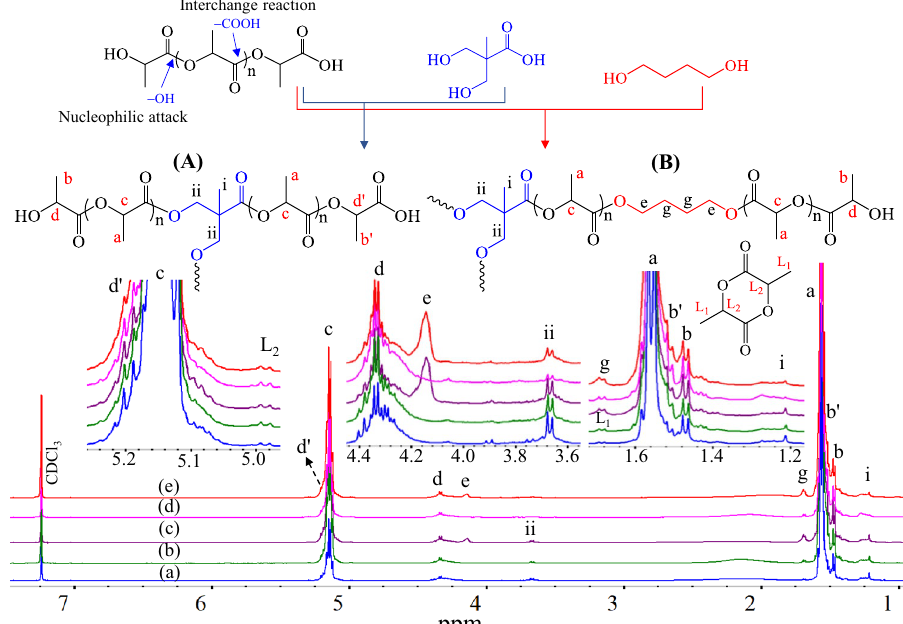
Figure 3. 1 H-NMR spectra and signal assignments of alcohol-acidolyzed PLA products: ( a ) LD6M, ( b )